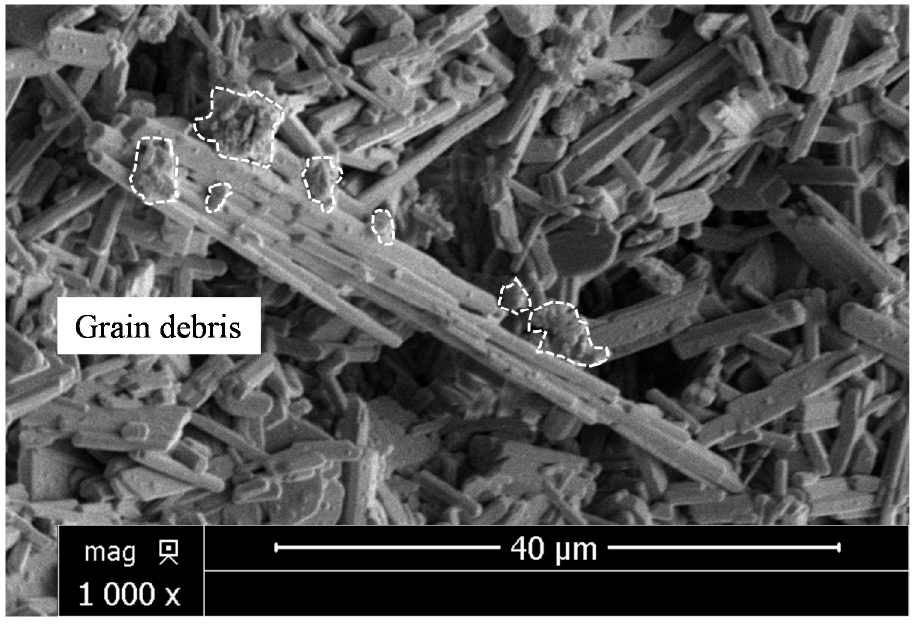
Figure 8. SEM scanning image of S1 (1000 times).